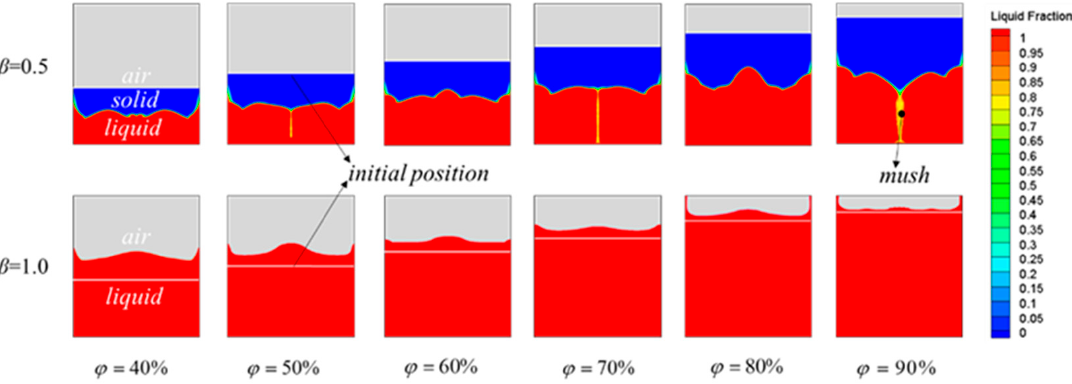
Figure 6. Phase fields at different φ values.